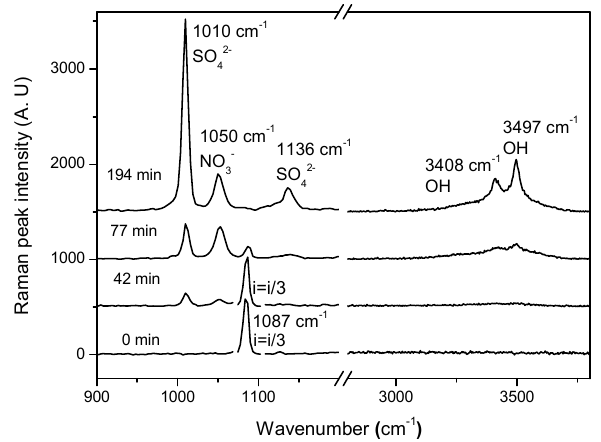
Figure 1. Raman spectra of a CaCO 3 particle during the multiphase reaction of SO 2 with O 2 / NO 2 / H 2 O on the particle. SO 2 : 75ppm, NO 2 : 75ppm, RH: 72%, O 2 : 20%. The peak intensity of carbonate (1087cm − 1 ) at 0 and 42min was divided by 3 for clarity.